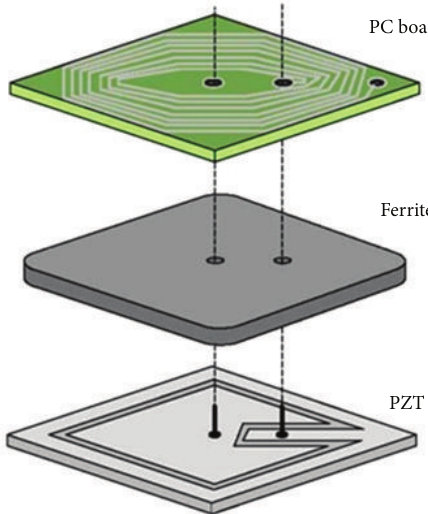
Figure 32: A planar transducer design using a coil on a printed circuit board [25].